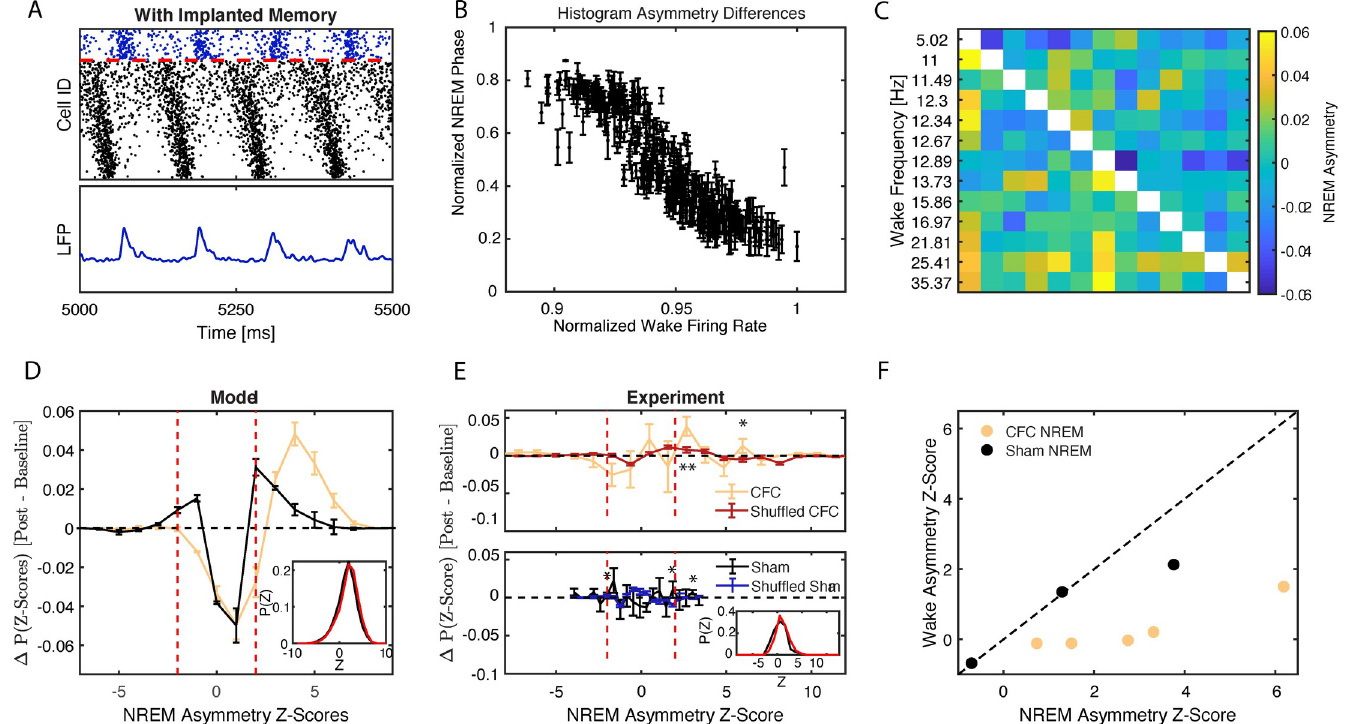
Fig 4. Mapping relative firing frequency distributions during wake onto firing phase relationships during NREM sleep. A) MODEL DATA: Calculation of mean phase of firing relative to oscillatory signal generated by inhibitory population; peaks in the inhibitory signal are used as the starting points of the phase calculation. B) MODEL DATA: Normalized phase of firing in NREM versus normalized wake frequency of excitatory neurons reveals that the neurons firing with the highest frequency align with an earlier phase of the excitatory network population whereas slower firing neurons align with later phases. C-F) Analysis of NREM firing asymmetry reveals enhanced wake frequency-dependent temporal relationships between neurons after learning. C) EXPERIMENTAL DATA: Formation of a pairwise firing asymmetry matrix of CA1 neurons’ activity recorded from a representative mouse during post-CFC NREM. Rows and columns have been arranged by wake frequency; color denotes pairwise firing asymmetry as defined in the Methods section. D) MODEL DATA: Weighted average of differences in distributions (see inset for a representative example scenario; black—baseline, red—post) of pairwise Z-scores for models with type 2 dynamics and learning (yellow) and with type 2 dynamics and no learning (black). E) EXPERIMENTAL DATA: Weighted average of differences in distributions (see inset in bottom panel for example of representative mouse; black—baseline, red—post) of pairwise Z-scores for NREM of CFC mice (top, yellow) and Sham mice (bottom, black), compared to differences in distributions calculated on random spike data following CFC (red, top) or Sham (blue, bottom) bursting architecture. F) EXPERIMENTAL DATA: Significance (Z-score) of global NREM network asymmetry vs. that of global wake asymmetry calculated for individual CFC (yellow) and sham (black) mice. Strong asymmetry is observed in NREM sleep but not in wake. Red dashed lines in ( D, E ) represent the significance cutoff of | Z | � 2. Error bars denote SE of repeated simulations ( D ) or SE across all experimental animals ( E ). � p < 0.05, �� p < 0.001 using a two-sided